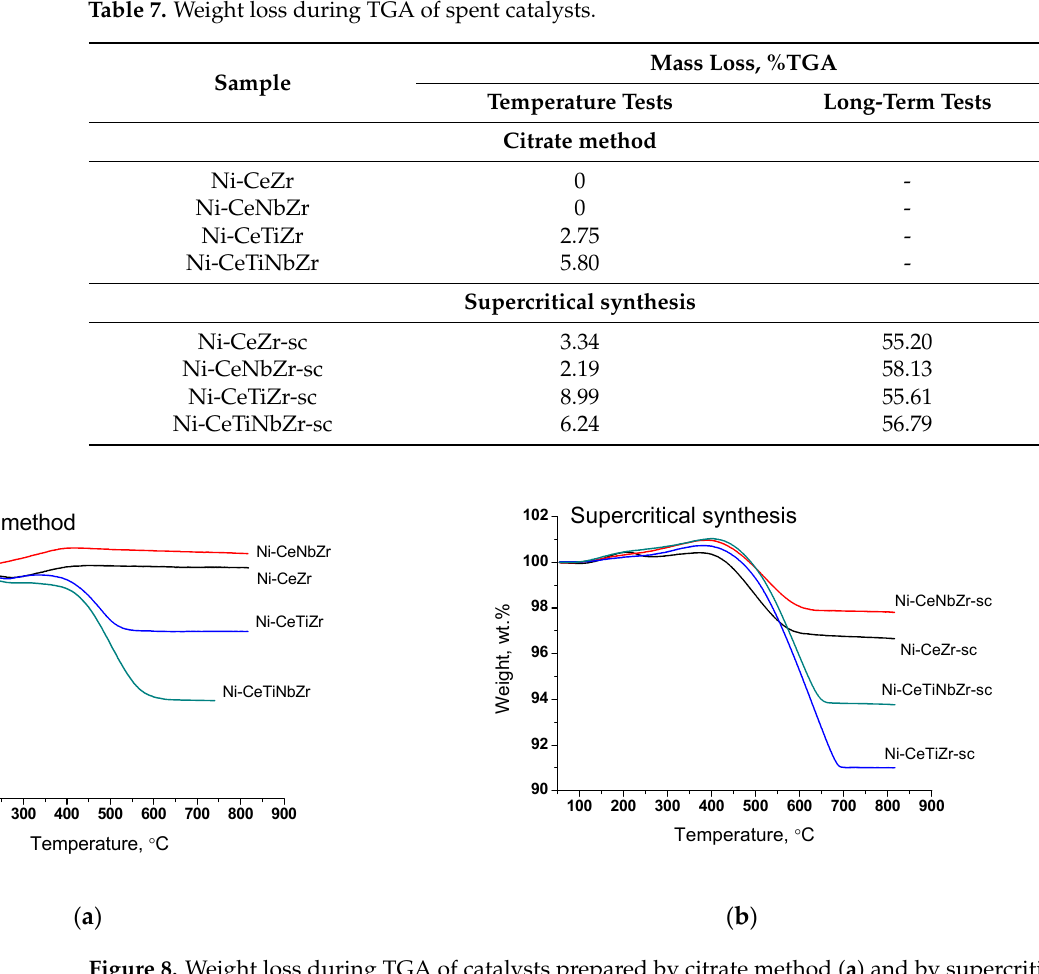
Figure 8. Weight loss during TGA of catalysts prepared by citrate method ( a ) and by supercritical synthesis ( b ) after tests in methane dry reforming.